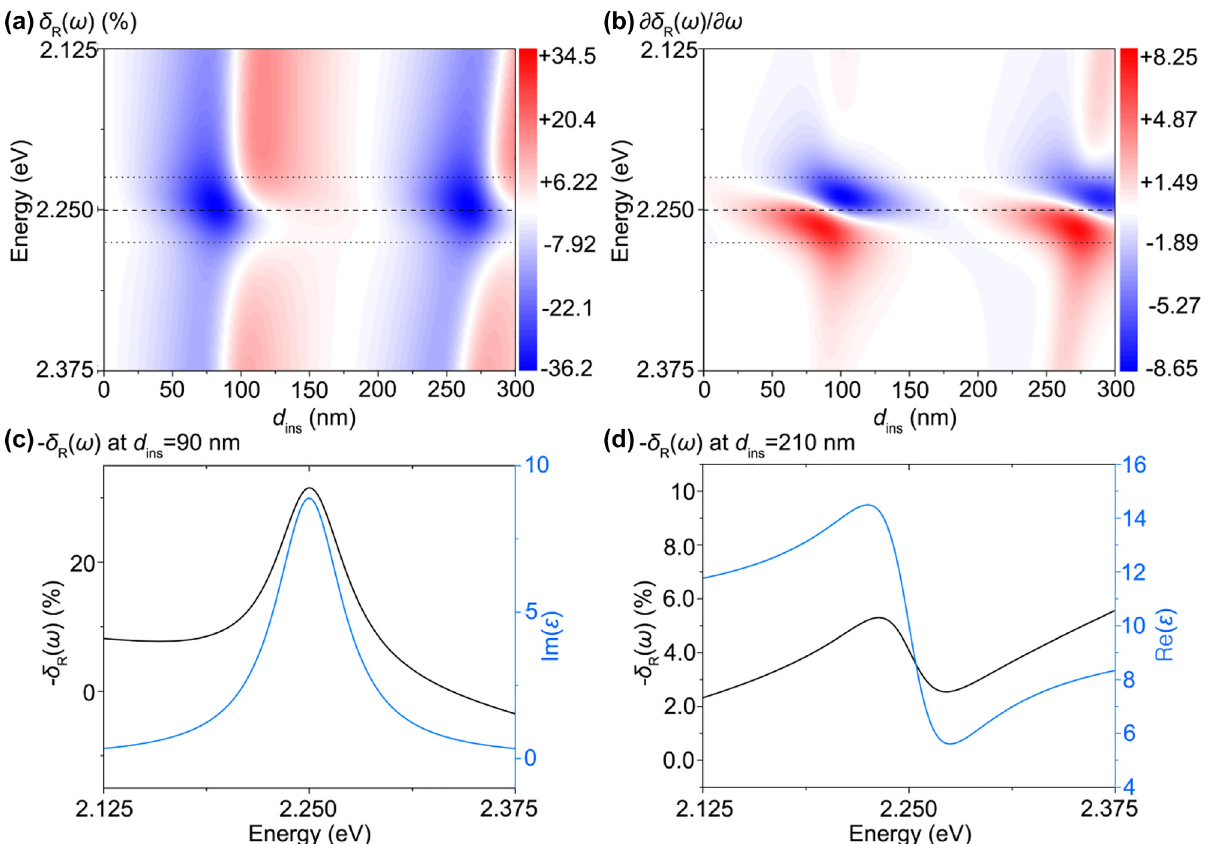
Figure 9: Limitation of reflection contrast spectroscopy. (a)Reflectioncontrastspectra δ R ( ω )ofa2Dmaterial/insulator/Sisubstrateaccordingtothicknessoftheinsulatinglayer d ins .(b)Derivativeof the re fl ection contrast spectra ∂ δ R ( ω )/ ∂ ω . The dashed lines correspond to the transition energy ( ħ ω 1 ) of 2.25 eV, while the dotted lines correspond to the linewidths ħ ( ω 1 − γ 1 )/2 ≤ ħ ω 1 ≤ ħ ( ω 1 + γ 1 )/2. Speci fi c examples of the re fl ection contrast spectra δ R ( ω ) of a 2D material/ insulator/Si substrate at (c) d ins = 90 nm and (d) d ins = 210 nm (black lines). The real and imaginary parts of the permittivity of the 2D